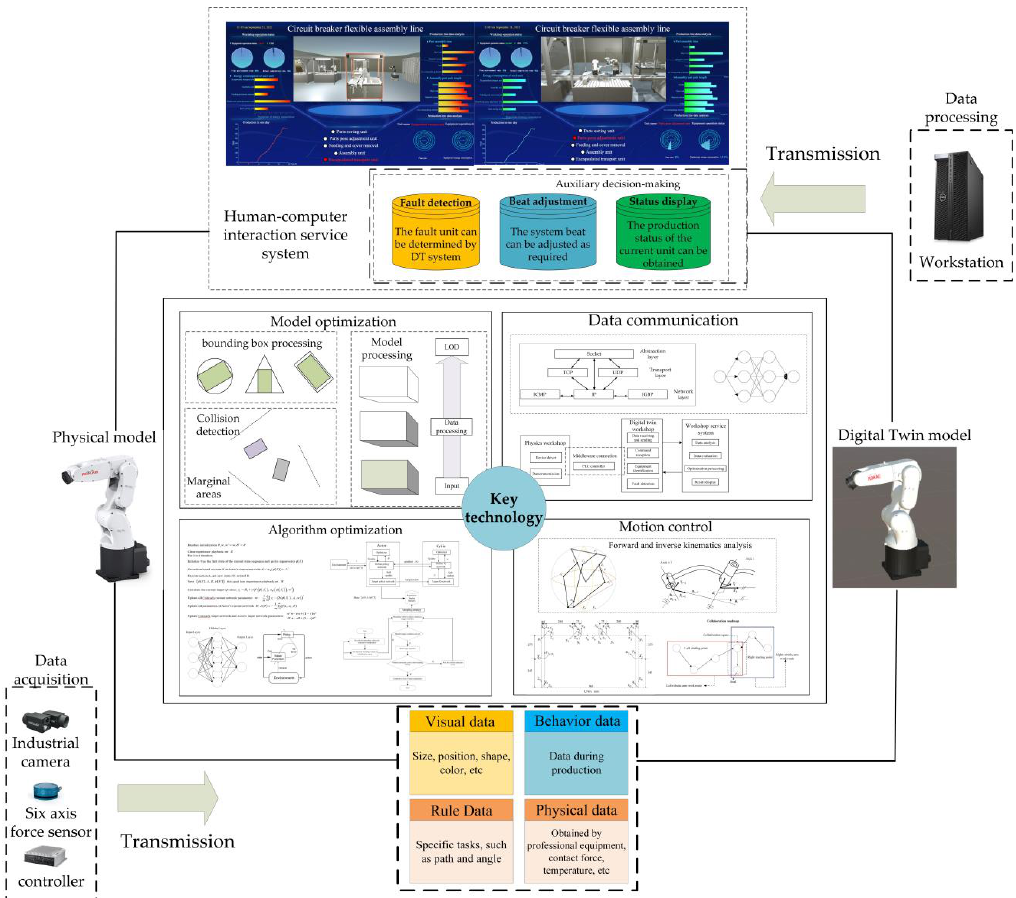
Figure 7. Framework of the DT flexible manufacturing system.